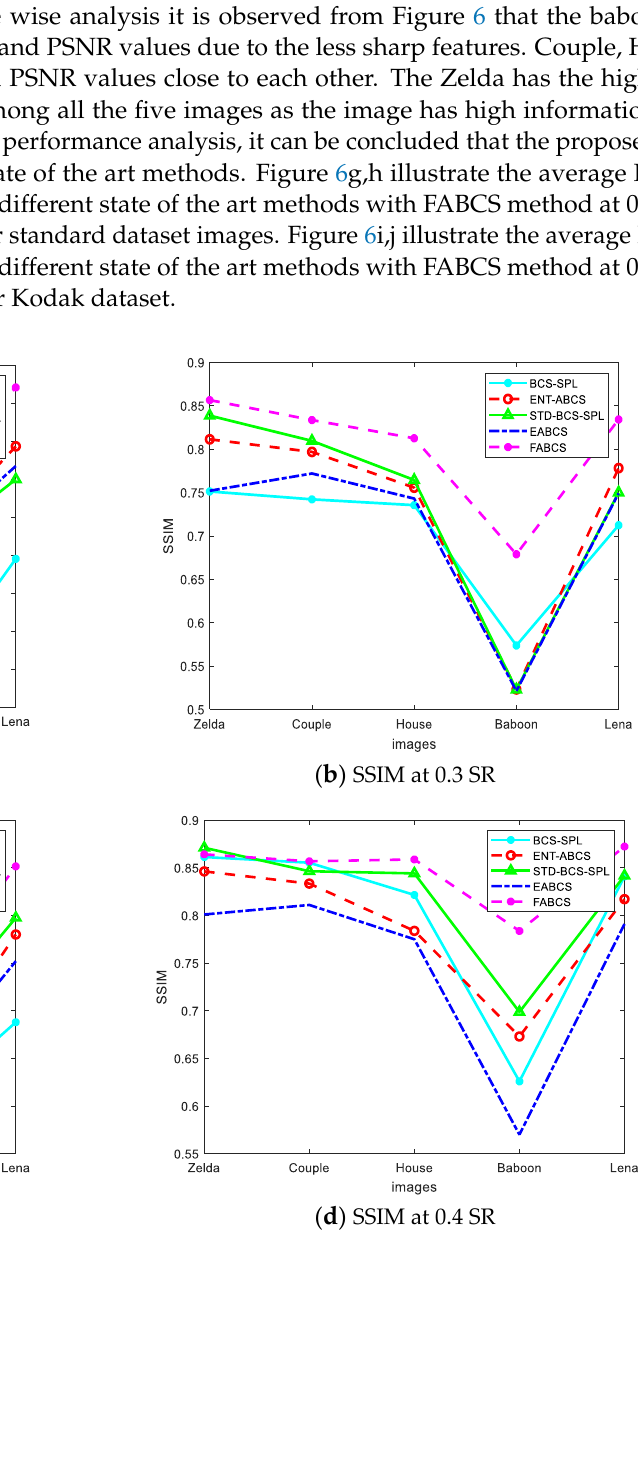
Table 3. Performance comparison of the state of the art methods at 0.5 SR on CCTV images.